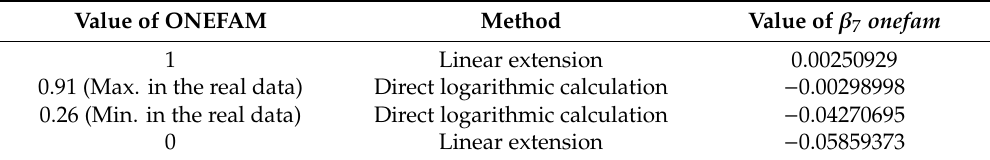
Table 3. Estimation results for per capita daily water demand for the log-log model.